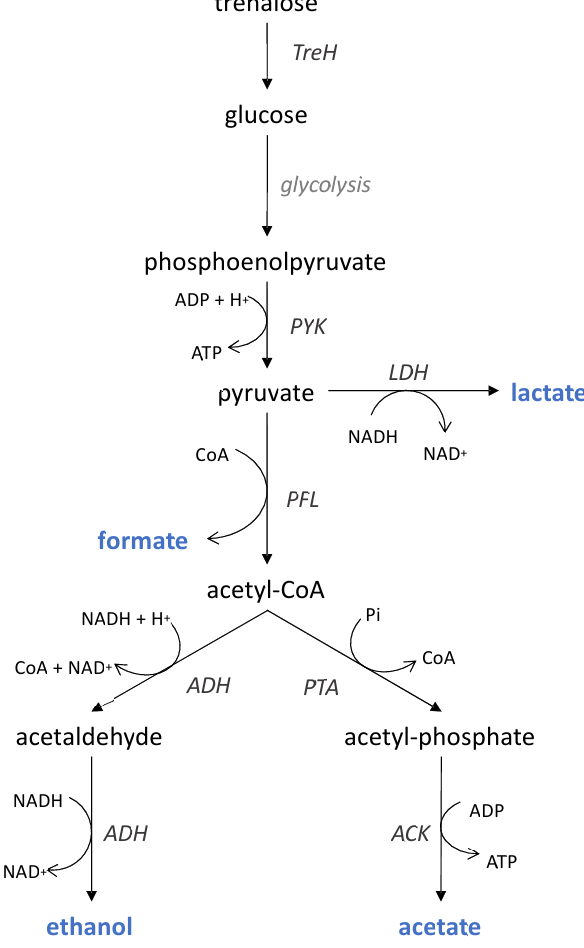
Figure 1. Mixed-acid fermentation pathway likely used by C. maltaromaticum to ferment trehalose. End products are shown in blue. ACK, acetate kinase; ADH, acetaldehyde dehydrogenase; LDH, lactate dehydrogenase; PFL, pyruvate formate lyase; PTA, phosphate acetyltransferase; PYK, pyruvate kinase; TreH, neutral trehalose. Adapted from [19–23].